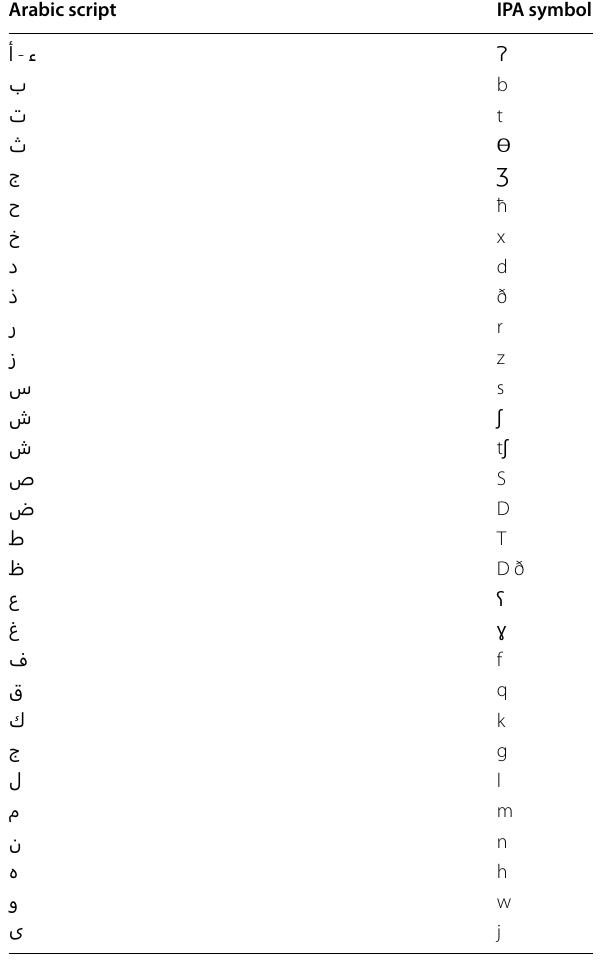
Table 1 Arabic transliteration alphabet Arabic script